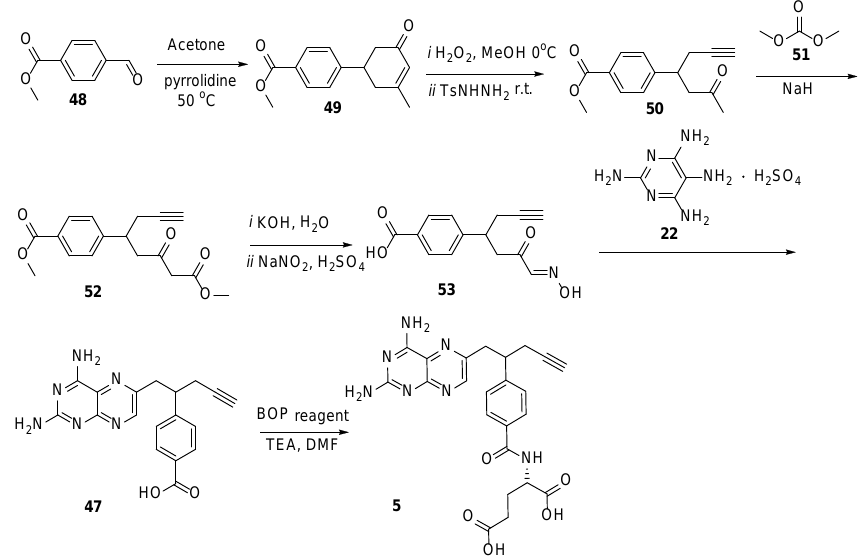
Scheme 21. Multistep synthesis of Pralatrexate starting from ethyl 4-formylbenzoate 48 .